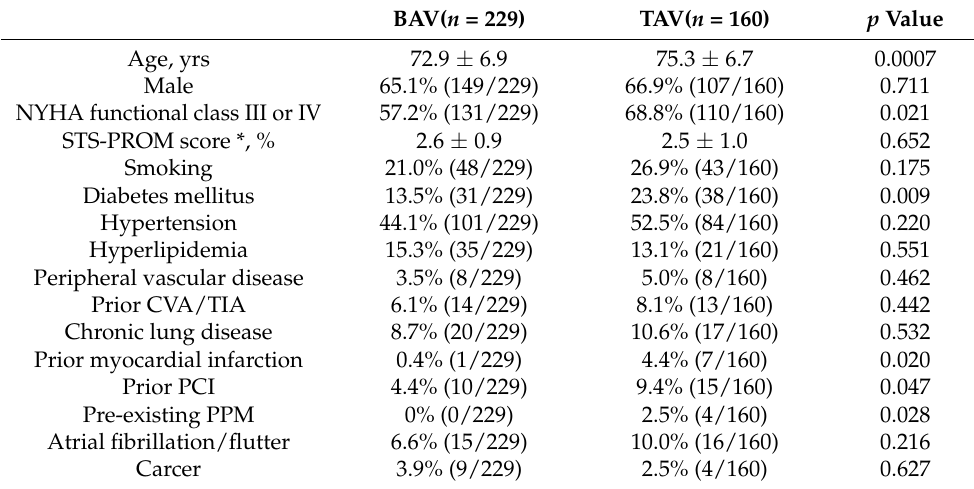
Table 1. Baseline Characteristics of Low-Risk